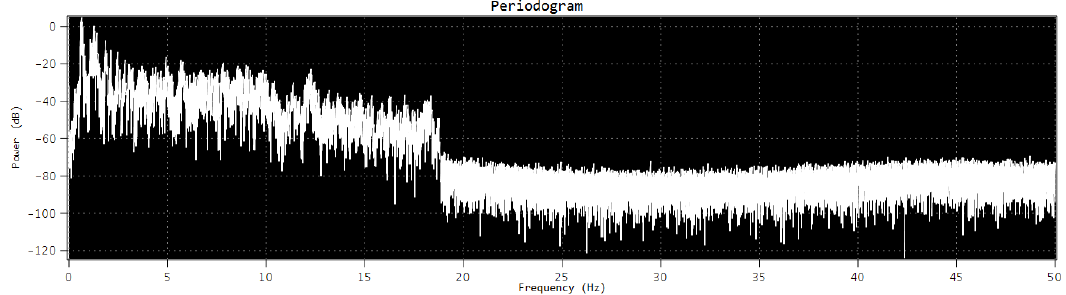
Figure 3. Periodogram of the previous signal (with sample rate